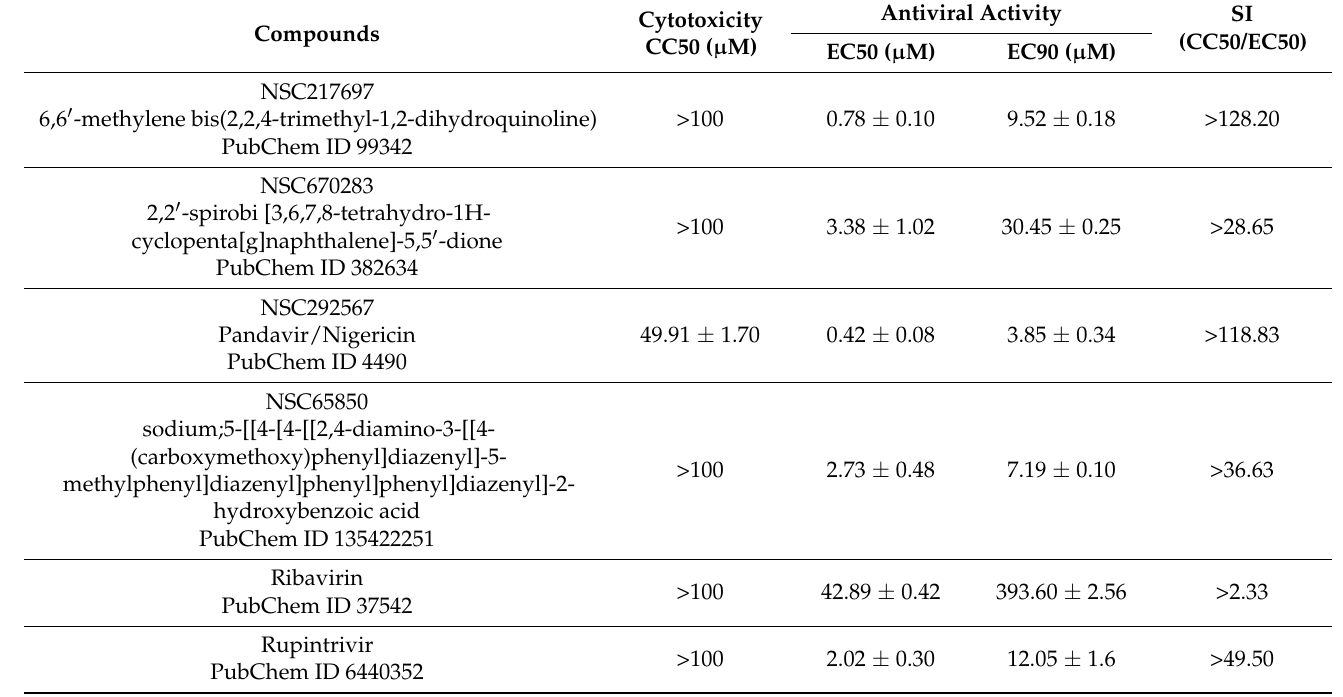
Table 2. The cell-based antiviral activity against FMDV infection and cytotoxicity of compounds in BHK-21